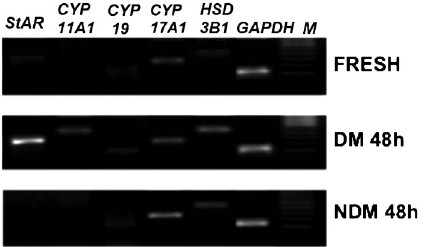
Figure 4. Characterization of mRNA expression in fresh and cultured ovarian follicle wall sections after 48 h of culture in defined medium (DM) or nondefined medium (NDM). Genes: StAR , CYP11A1 , CYP19 , CYP17A1 , HSD3B1 , and the GAPDH housekeeping gene. M : molecular